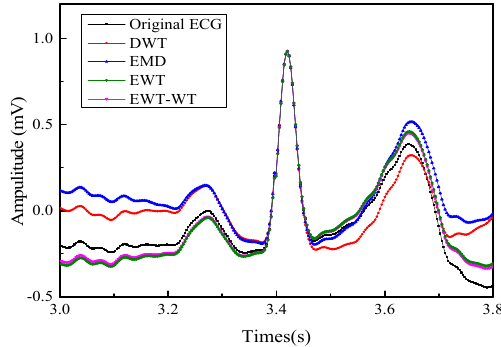
Figure 10. The original ECG and the denoised ECG using various methods for a real